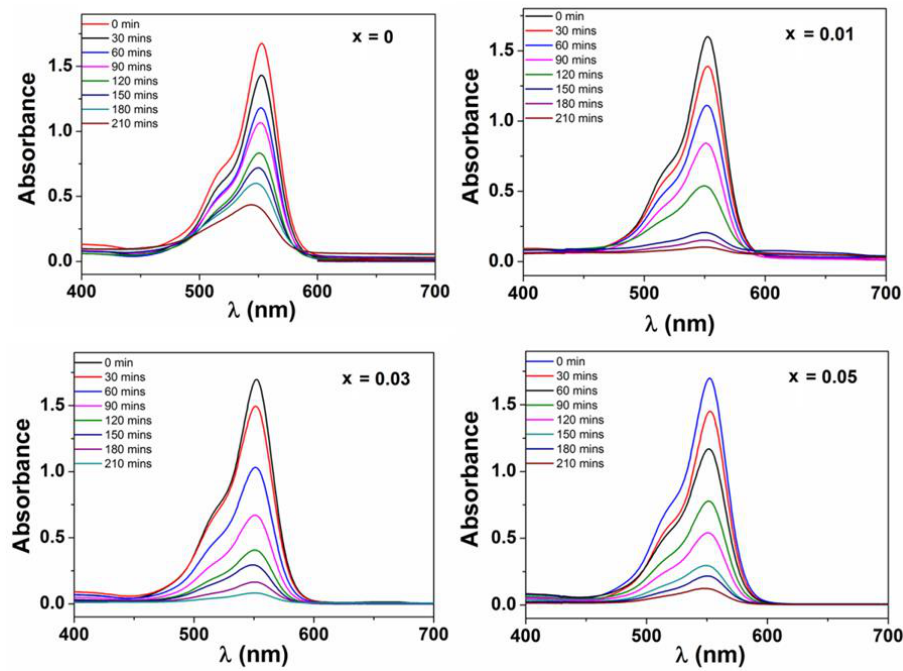
Figure 8. The change in absorption of Rhodamine B solution with time in the presence of H 2 O 2 and ZnNd x Fe 2−x O 4 nanoparticles (x = 0–0.05) under irradiation.